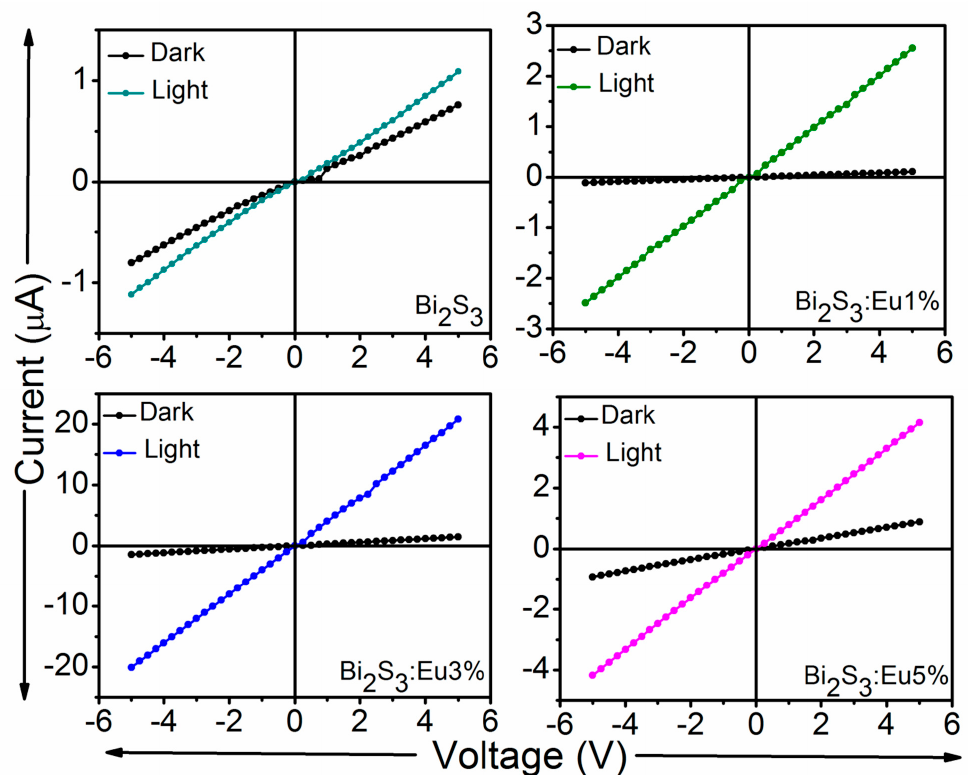
Figure 7. Semi-log I–V characteristics of the fabricated Eu-doped Bi 2 S 3 photosensor measured under dark and illuminated conditions at a bias voltage between − 5 and +5 V, prepared using different Eu doping concentrations.